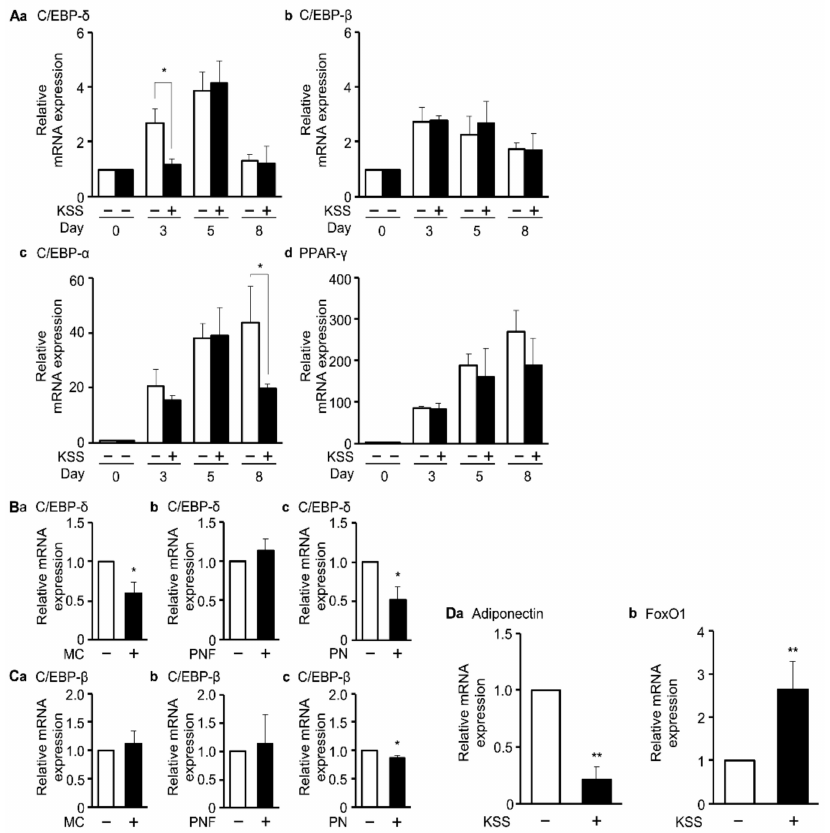
Figure 6. KSS, MC, and PN suppress C / EBP- δ gene expression. ( A ) KSS suppresses di ff erentiation marker gene expression in a time-dependent manner. The gene expression level was quantified by the qPCR method. ( Aa ) C / EBP- δ , ( Ab ) C / EBP- β , ( Ac ) C / EBP- α , ( Ad ) PPAR- γ . ( B , C ) During di ff erentiation induction, MC (1 mg / mL), PNF (1000 µ M), and PN (1000 µ M) were administered, and the expression level of the C / EBP- δ and C / EBP- β genes was quantified as in ( A ). ( a ) MC, ( b ) PNF, ( c ) PN. ( D ) Alteration of the expression level of ( Da ) Adiponectin and ( Db ) FoxO1 during di ff erentiation induction with or without KSS. Data are shown as mean ± standard deviation ( n = 3). * p < 0.05 and ** p < 0.01 vs. H 2 O or